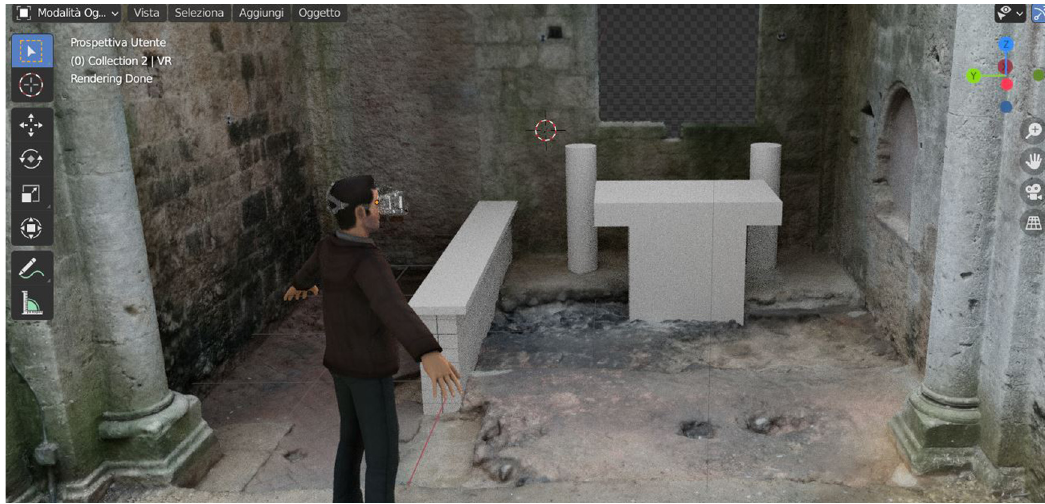
Figure 11: San Galgano project: 3D rendering and